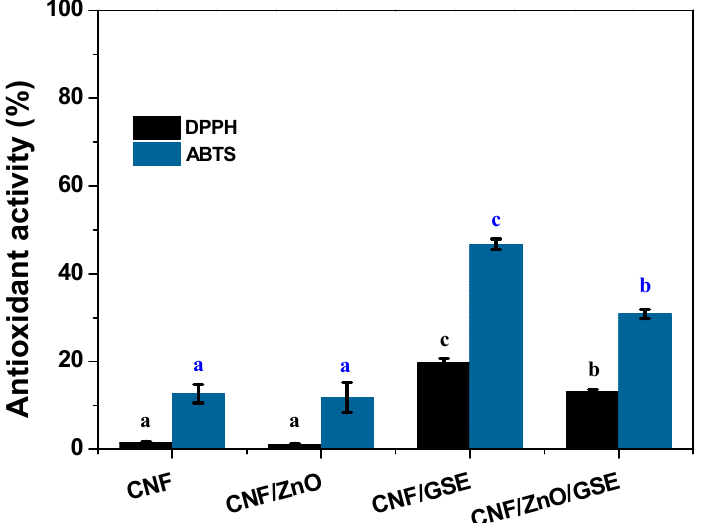
Figure 9. Antioxidant activity of CNF/ZnO/GSE films. Data with the same superscript letter within the same column are not significantly ( p > 0.05) different from Duncan’s multiple range tests.